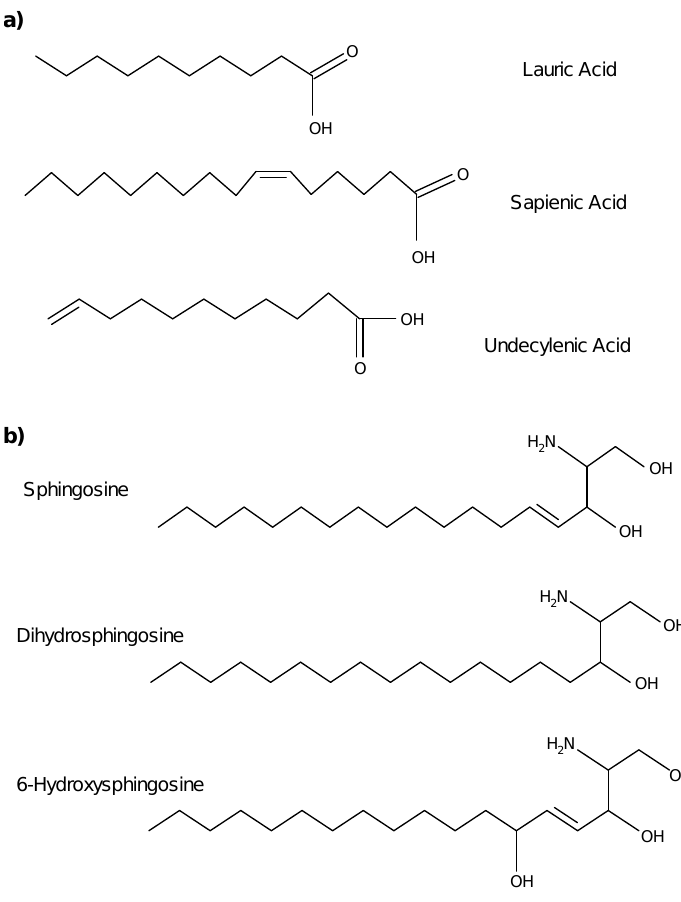
Figure 1. The chemical structures of antimicrobial lipids (AMLs) found on the surface of the skin and oral mucosa. ( a ) Sapienic acid is the major free fatty acid derived from sebum and lauric acid is the minor fatty acid derivative of sebum. Fatty acids demonstrating antimicrobial activity are generally 12–18 carbons and activity quickly decreases with either longer or shorter chains. Undecylenic acid is derived from sweat and also present on the skin surface. ( b ) Free sphingoid bases are derived from the stratum corneum, liberated via ceramidases, and exhibit broad antimicrobial